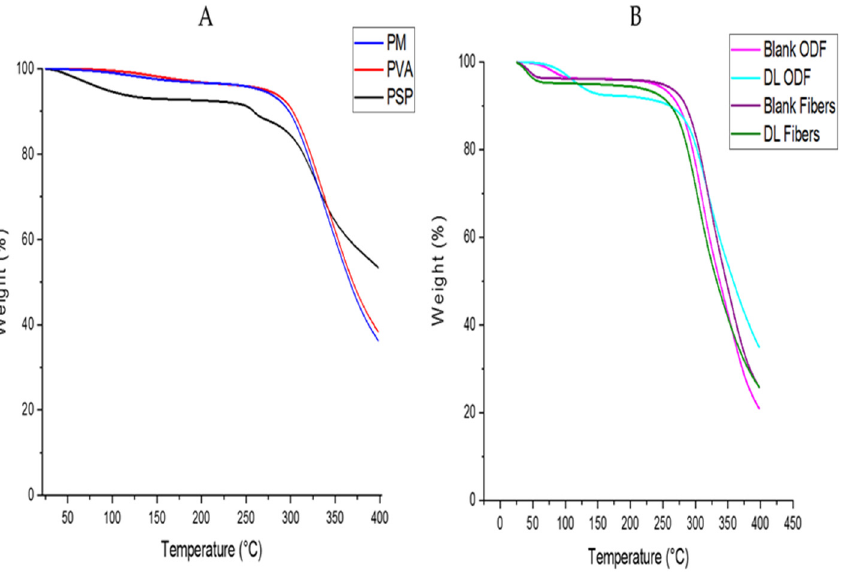
Figure 4. Thermogravimetric analysis (TGA) showing the decomposition temperature of ( A ); PSP, PVA and physical mixture (PM), ( B ); blank and Drug Loading (DL) nanofibers and